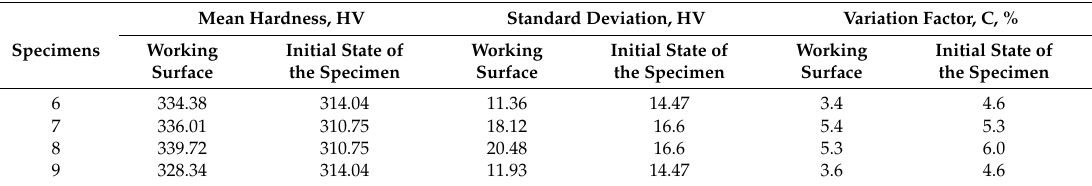
Table 2. Statistical characteristics of scatter of the measured hardness values of the investigated specimens (see also Figure 5).